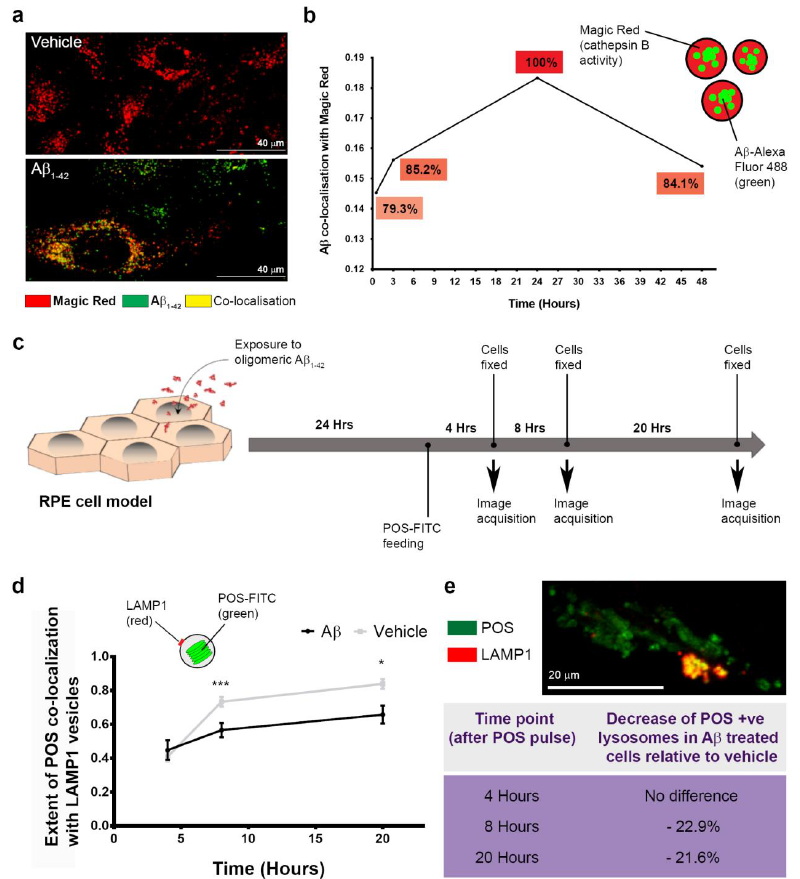
Figure 8. The pattern of Aβ aggregation in RPE lysosomes and consequences to RPE function. ( a ) Representative confocal immunofluorescence image showing a high proportion of late-endocytic compartments positive for Aβ 1-42 (green), which co-localize with Magic Red to appear yellow. Scale bars correspond to 40 μm. ( b ) Dynamics of Aβ 1-42 entry into lysosomes of RPE cells shown relative to vehicle-treated cultures, which reached an arbitrary point of maximal aggregation after 24 h. Only minimal degradation of the Aβ fluorescence signal was observed after 24 h following maximal aggregation (or by 48 h after initial Aβ exposure). Consequently, ˃ 80% of Aβ present at the 24 h time point remained sequestered with RPE lysosomes a day later. Data from three biological replicates. ( c ) Schematic showing experimental plan where RPE cultures exposed to either Aβ 1-42 or vehicle were fed with POS a day later, and co-localization with LAMP1 vesicles quantified thereafter at 4, 8 and 20 h. ( d ) Graph showing extent of POS co-localization in LAMP1 vesicles after POS feeding. Two- tailed unpaired Student’s t -test. Data from three biological replicates, where * denotes a significance of p ˂ 0.05, whilst *** indicate p ˂ 0.001. ( e ) Representative confocal-immunofluorescence image showing POS-FITC (green) co-localizing with LAMP1 compartments (red) and appear yellow. Scale bar corresponds to 20 μm. Summary table showing percentage decrease in LAMP1-positive vesicles with POS cargos at different time points after POS feeding in Aβ-treated cells relative to vehicle. Aβ-exposed RPE had significantly fewer lysosomes capable to trafficking POS cargos after 8 h.